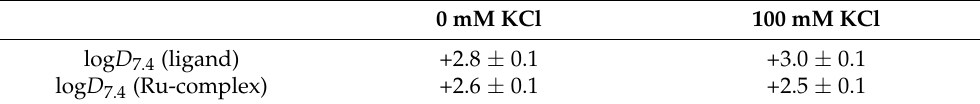
Table 3. Distribution coefficients ( D 7.4 ) measured for the studied compounds [pH = 7.4 (10 mM HEPES)].